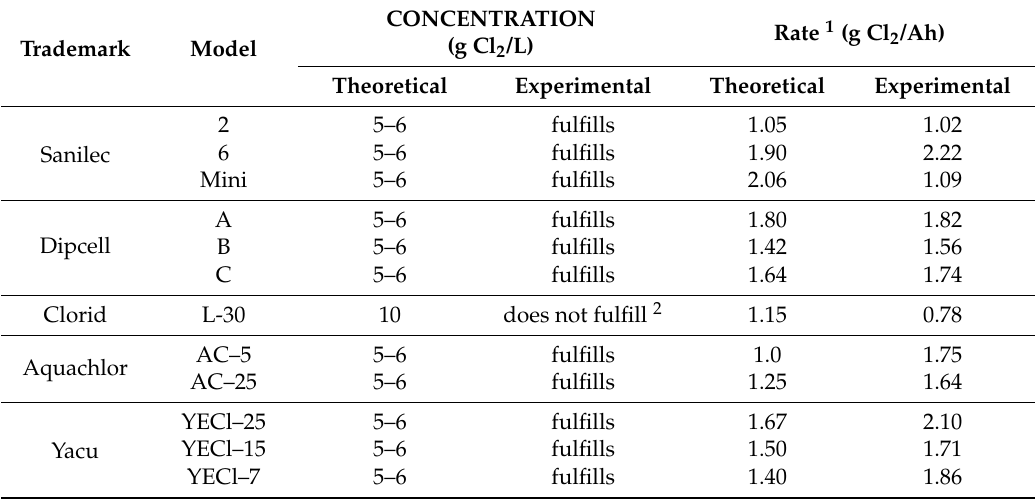
Table 1. Comparison among average rate of hypochlorite production as a function on